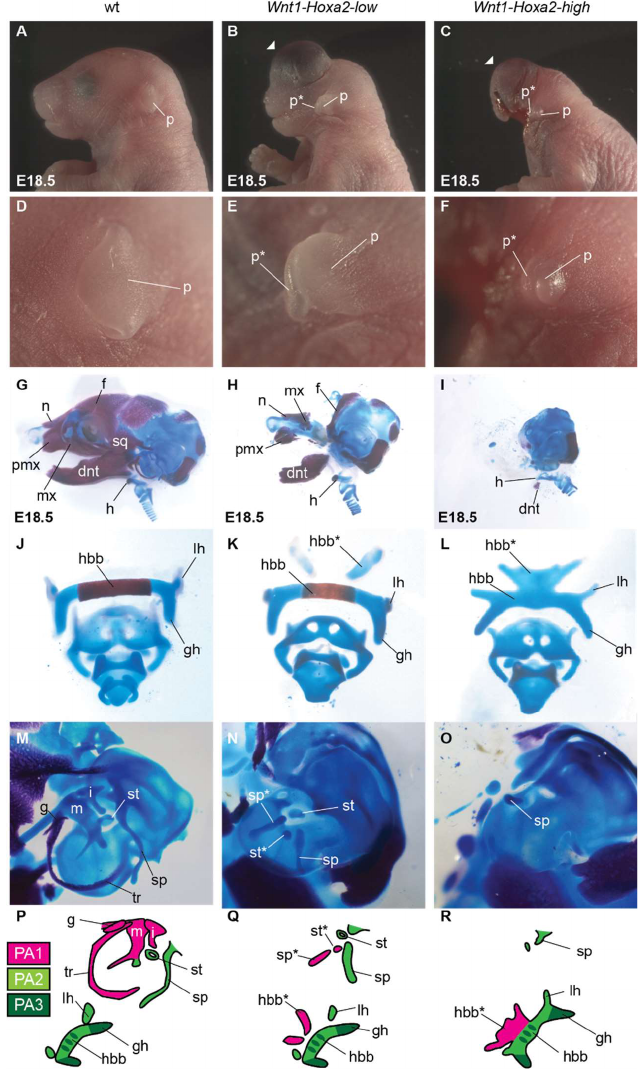
Figure 2. Craniofacial phenotypes of Wnt1-Hoxa2-low and Wnt1-Hoxa2-high mouse fetuses. E18.5 wild-type (wt, A , D , G , J , M , P ), Wnt1-Hoxa2-low ( B , E , H , K , N , Q ) and Wnt1-Hoxa2-high ( C , F , I , L , O , R ) fetuses are compared. ( A – C ) Lateral views of facial appearance. Short snout and exencephaly (ar- rowheads) are more severe in Wnt1-Hoxa2-high fetuses. ( D – F ) Higher magnification of the pinna. Duplication of the pinna is observed in both Wnt1-Hoxa2-low ( E ) and Wnt1-Hoxa2-high ( F ) specimen; in ( F ), normal and ectopic pinnae are hypoplastic. ( G – I ) Lateral views of head and neck skeletal staining. In ( I ), structures are absent or hypoplastic, more than in ( H ). ( J – L ) Higher magnification of the hyoid region. In Wnt1-Hoxa2-low ( K ), the ectopic body of the hyoid bone (hbb*) is present in only 70% of the mutant fetuses. In Wnt1-Hoxa2-high ( L ), a malformed hbb* is always present. ( M – R ) Higher magnification of the middle ear and hyoid regions ( M – O ) and their schematic repre- sentations ( P – R ). Skeletal elements derived from PA1 (magenta), PA2 (light green) and PA3 (dark green) are labelled. dnt, dentary; f, frontal; g, gonial; gh, greater horn of hyoid bone; h, hyoid bone; hbb, body of hyoid bone; i, incus; lh, lesser horn of hyoid bone; m, malleus; mx, maxillary; n, nasal; p, pinna; pmx, premaxillary; PA, pharyngeal arch; sp, styloid process; sq, squamosal; st, stapes; tr, tympanic ring; *, duplicated